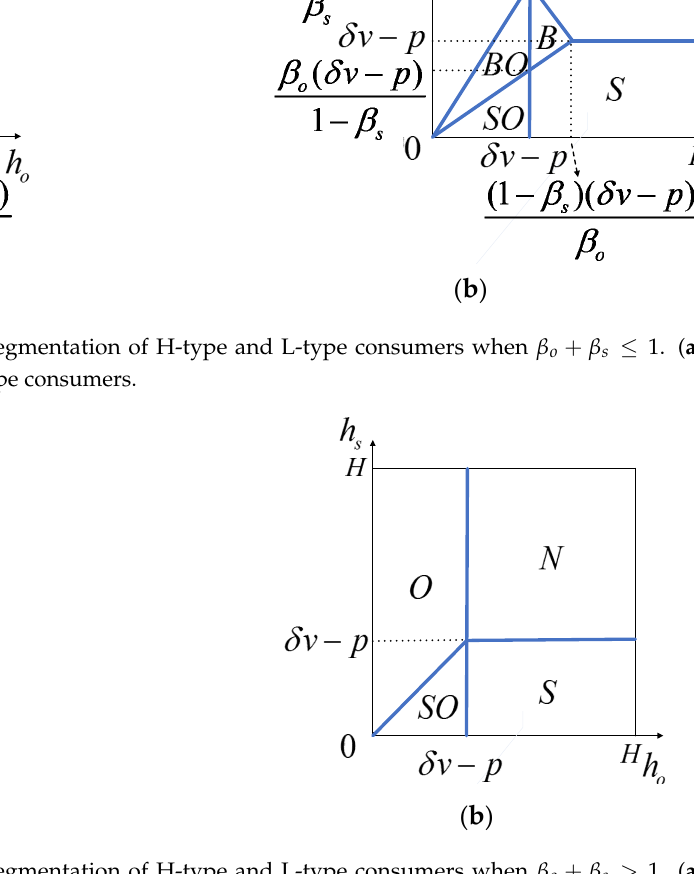
Figure 1. Market segmentation of H-type and L-type consumers when